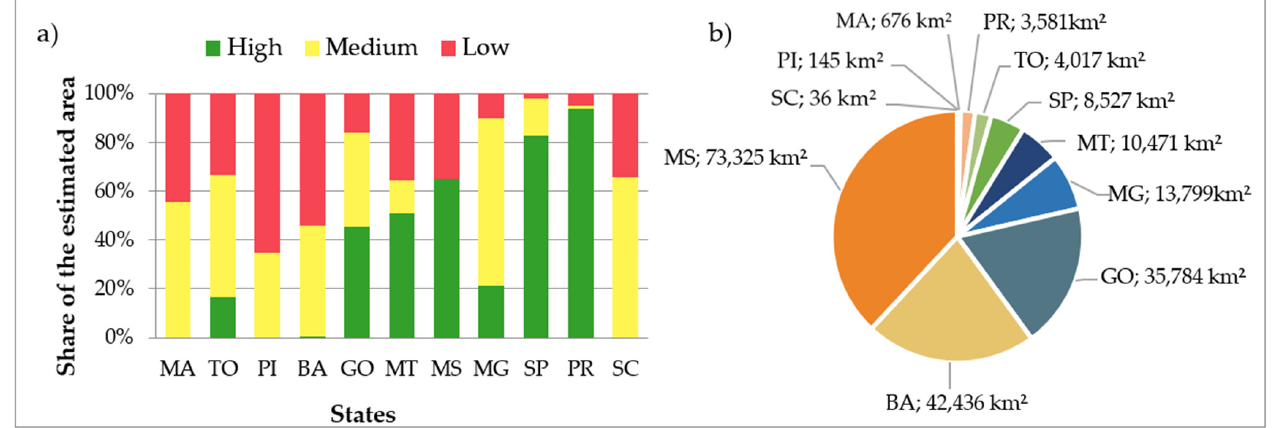
Figure 5. ( a ) Share of the estimated available areas according to the suitability for soy, in percentage, in the assessed states; ( b ) Total available area in each state. No available area was identified in one of the states, RS, after smoothing and aggregation of pixels.